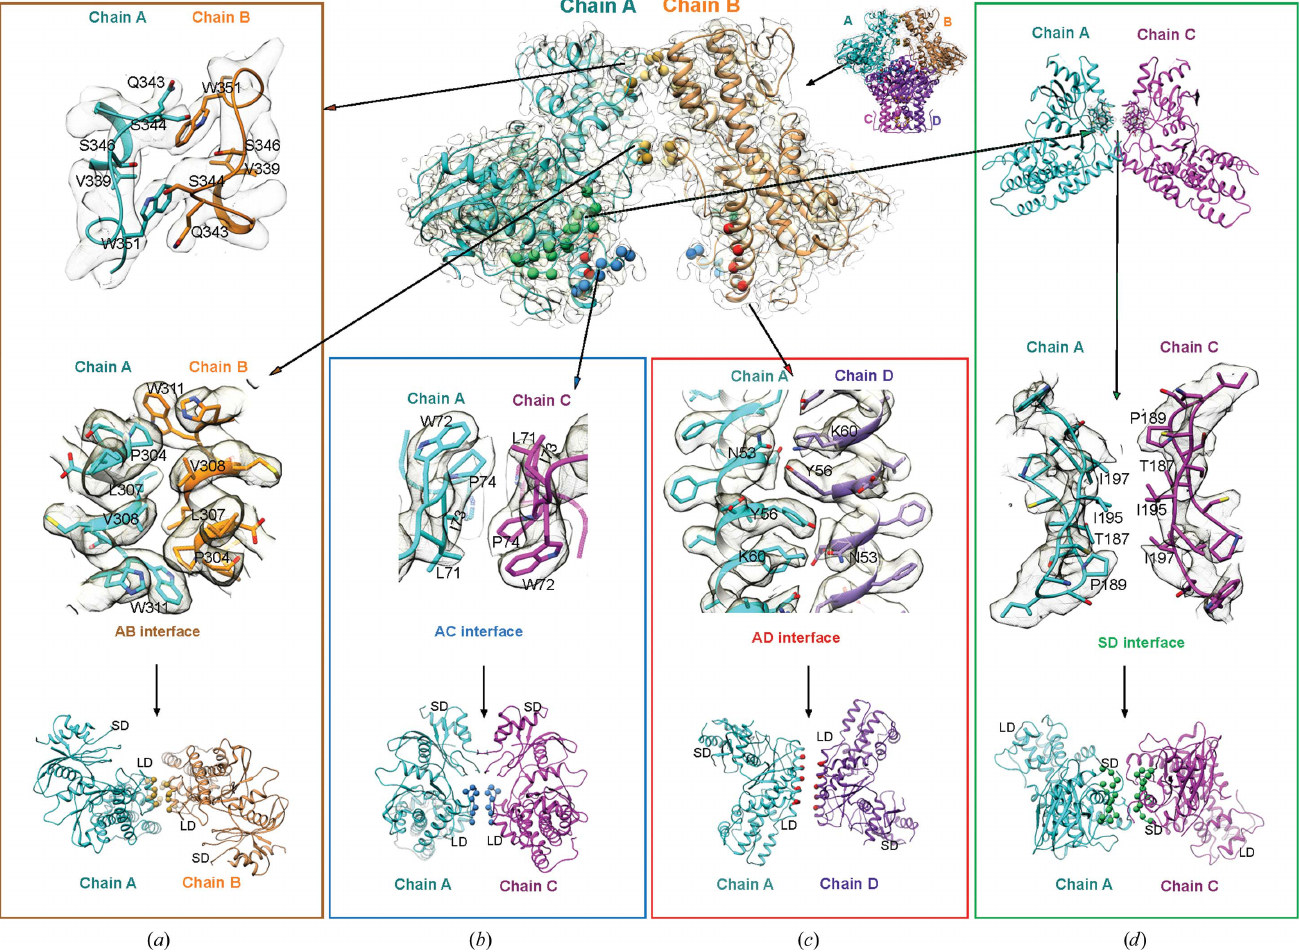
Figure 3 Molecular interactions of the PvHK tetramer. Four distinct interfaces are highlighted by coloring C (cid:3) atoms as golden spheres for residues in the AB interface, blue spheres for the AC interface, red spheres for the AD interface and green spheres for the SD interface. The interatomic interactions at the three interfaces between large domains are shown for the ( a ) AB, ( b ) AC and ( c ) AD interfaces. ( d ) The SD interface between PvHK small domains. Insets show the interactions at the residue level along with the cryo-EM